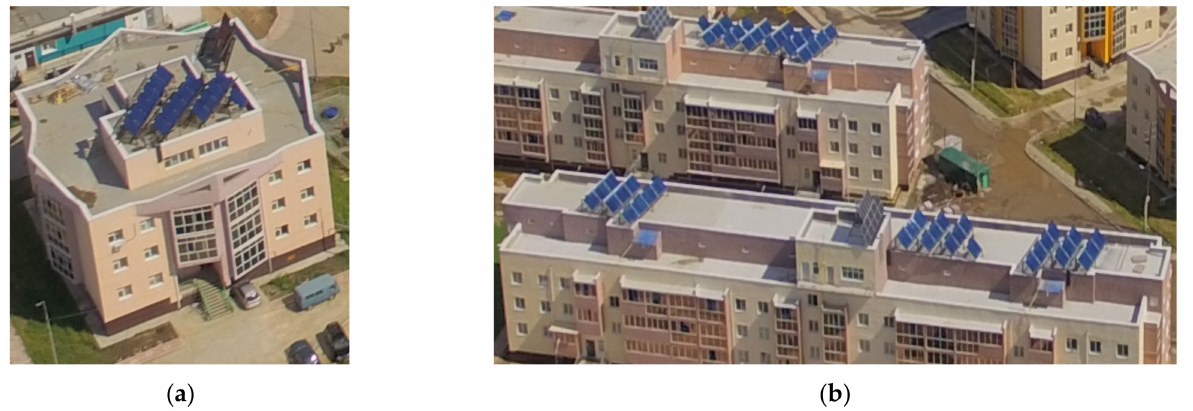
Figure 1. Energy-efficient residential buildings with a PV system and an HHWS: ( a ) house with one entrance; ( b ) house with three entrances.